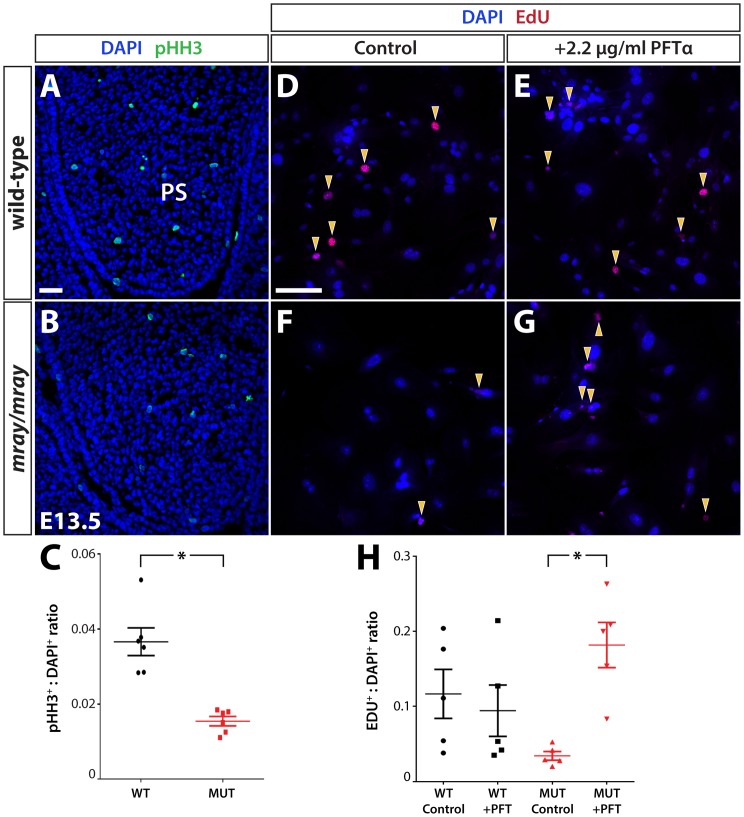
Proliferation deficits in mray/mray embryos can be rescued in vitro by Tp53 inhibition.Coronal sections through the palatal shelves of wild-type (A) and mray/mray mutant embryos (B) at E13.5 demonstrate a severe reduction in mitotic cells in the mutant as detected by pHH3 immunofluorescence. The quantification of the results is shown in C as a ratio of pHH3+ to DAPI+ cells. * represents a p-value <0.02. EdU cell proliferation assay on cultured primary facial fibroblasts from wild-type (D) and manta-ray homozygous mutants (F) reveals a reduced rate of proliferation in mutant cells. This deficit can be averted by treatment with the Tp53 inhibitor pifithrin-α, which significantly increased cell proliferation in mutant cells, but had no apparent effect on wild-type cells as shown in the quantification in H given as a ratio of EDU+ to DAPI+ cells. A total of five independent fields were analyzed between three slides for the experiment. EDU+: DAPI+ ratios for individual fields are represented by the circles (WT control), squares (WT + PFTα), triangles (MUT control) and upside down triangles (MUT + PFTα). Middle bar represents the mean value, with top and bottom bars representing standard error of the mean. * represents a p-value <0.02. EDU+: DAPI+ ratio was not significantly different between WT control, WT + PFTα, and MUT + PFTα groups. MUT: mutant, PS: palatal shelves, WT: wild-type. Scale bars are 30 μm.